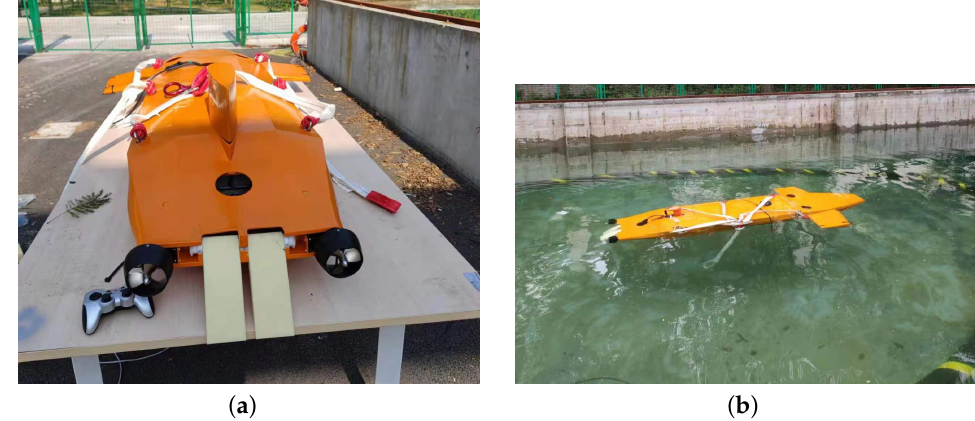
Figure 1. ( a ) Typical autonomous underwater vehicle model; ( b ) an autonomous underwater vehicle underwater